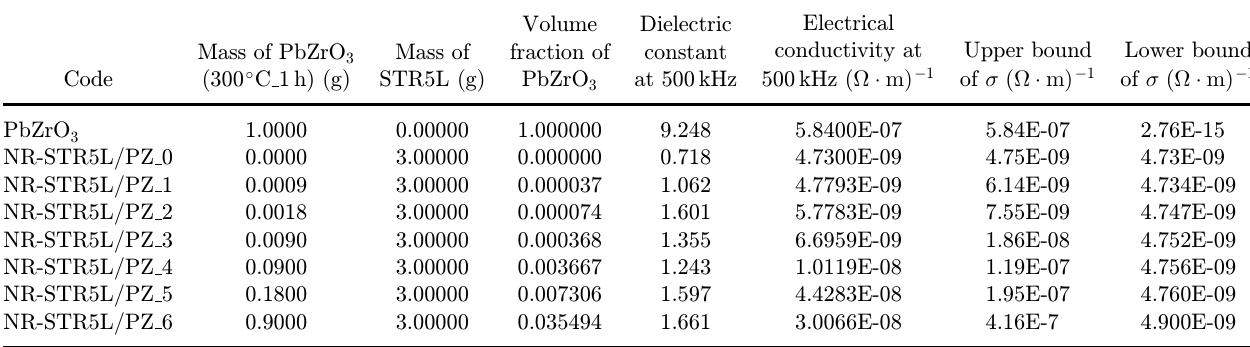
Table 2. Electrical properties of NR-STR5L/PbZrO 3 composites measured at 27 (cid:5) 1 (cid:2) C, and 500 kHz.